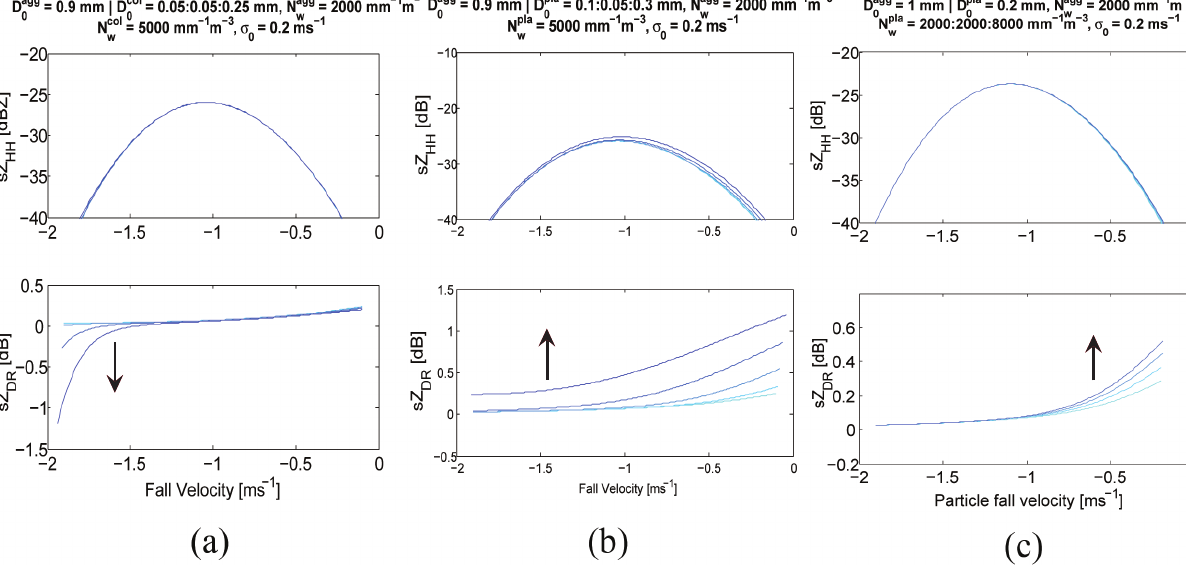
Fig. 2. Simulations of sZ HH (v) and sZ VV (v) obtained for different microphysical configurations. For all simulations, a mix of two particle types is considered. All particle shapes are approximated with spheroids and they all follow an exponential distribution. D 0 corresponds to the Median Volume Diameter, N w is the intercept parameter (related to the particle concentration) and σ 0 is the spectral broadening parameter (related to the atmospheric turbulence within the volume considered). (a) Mixing of aggregates and columns obtained for an increase of the column crystals diameter. (b) Mixing of aggregates and plates obtained for an increase of the plate crystals diameter. (c) Mixing of aggregates and plates obtained for an increase of the plate crystals concentration.